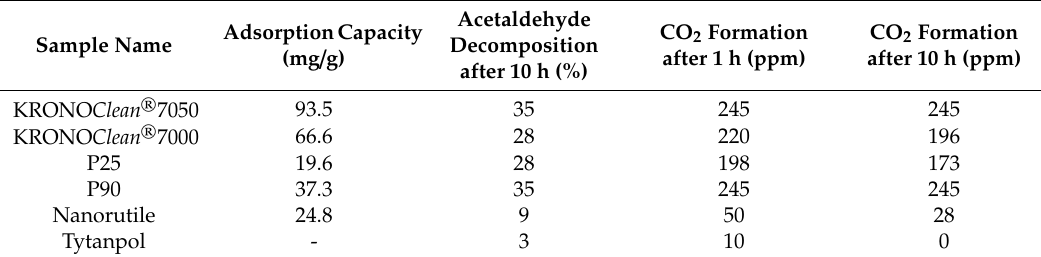
Table 3. Adsorption capacities and decomposition degree of acetaldehyde on studied